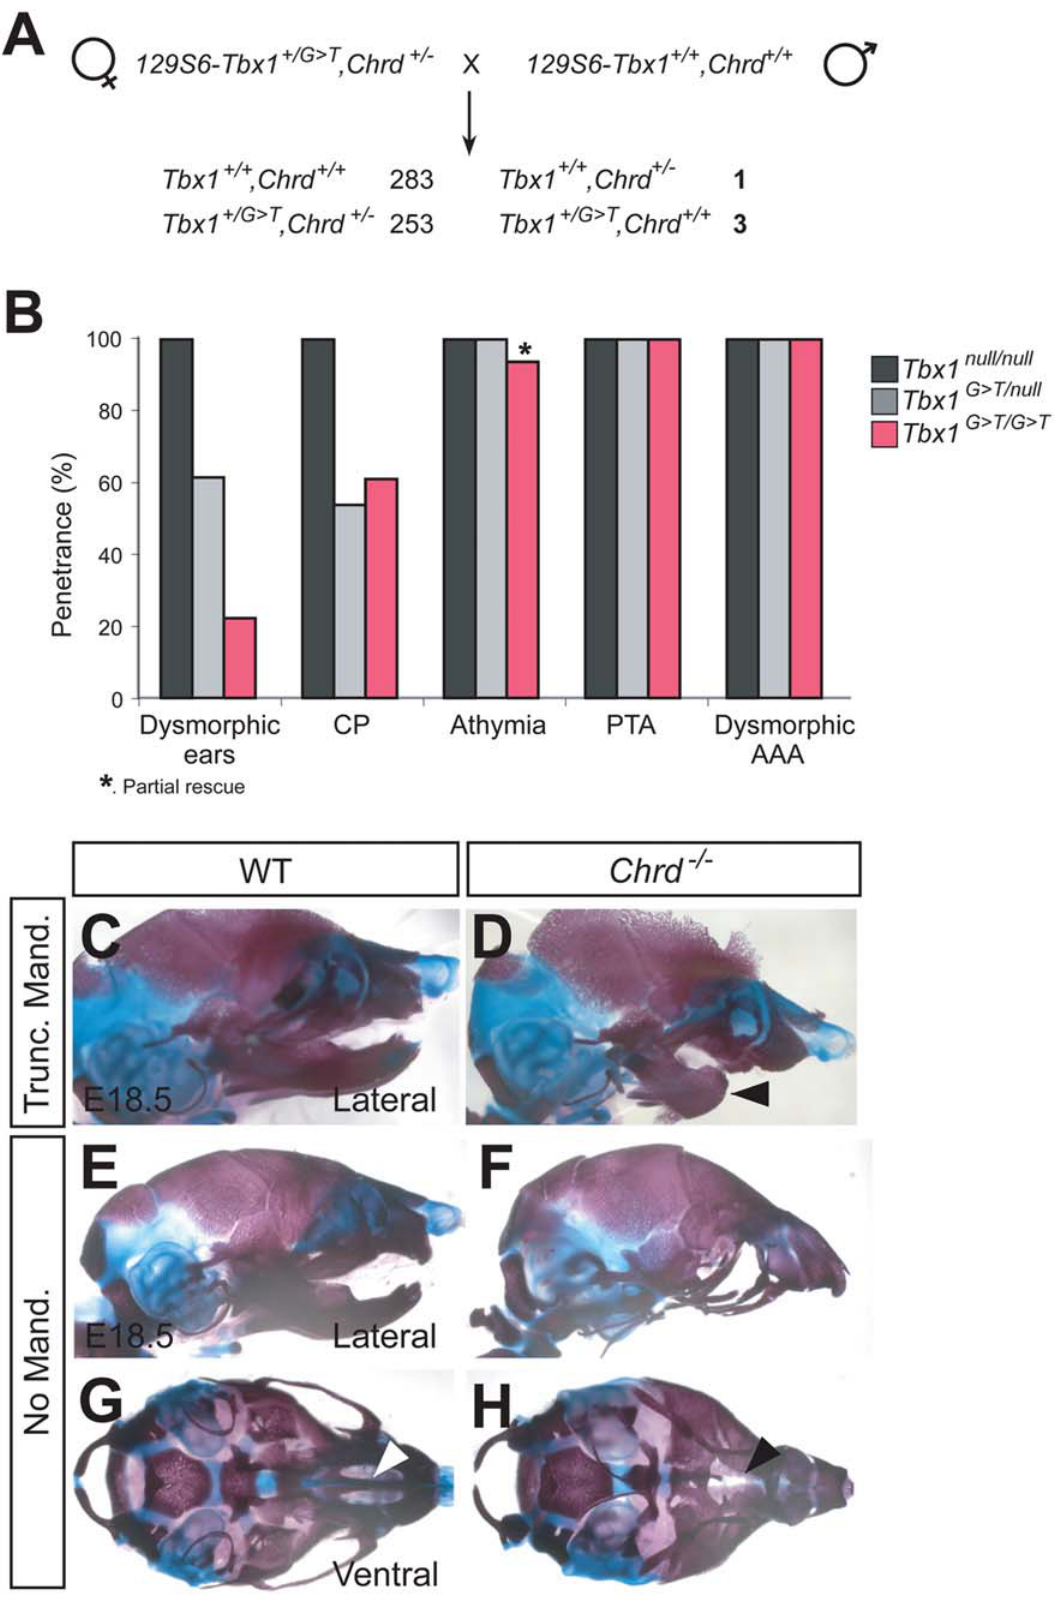
Figure 3. Phenotypes of Chrd + / + ,Tbx1 G . T/G . T and Chrd 2 / 2 ,Tbx1 + / + mutant embryos. (A) Crossing scheme to generate recombinant animals. 129S6- Chrd + / 2 females were mated with 129S6 wild-type studs and offspring were screened for recombination of markers. (B) Penetrance of five phenotypes associated with DGS from each different Tbx1 mutant class, displaying dosage-dependent rescue of craniofacial phenotypes. (C–H)